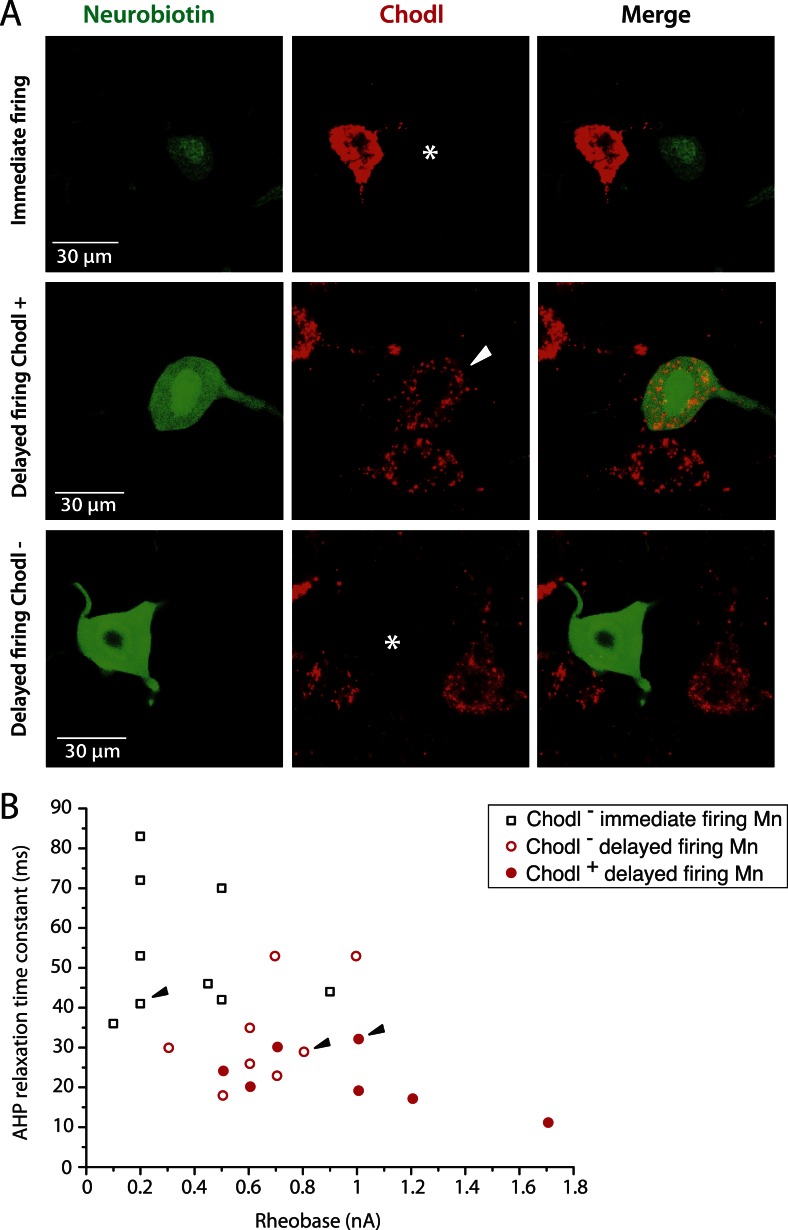
The largest delayed firing motoneurons express chondrolectin mRNA contrary to immediate firing motoneurons.(A) Examples of chondrolectin in situ hybridizations (red) in neurobiotin filled motoneurons (green). The asterisks in the first and third rows indicate that the cell body of the recorded motoneuron was chondrolectin negative. The arrowhead in the second row indicates that chondrolectin is expressed in this delayed firing motoneuron. (B) Plot of the AHP relaxation time constants against the rheobase for the investigated motoneurons. About half of the delayed firing motoneurons (the ones that display the highest rheobase) were chondrolectin-positive. All the immediate firing motoneurons were chondrolectin-negative. Arrowheads point to the motoneurons illustrated in A.